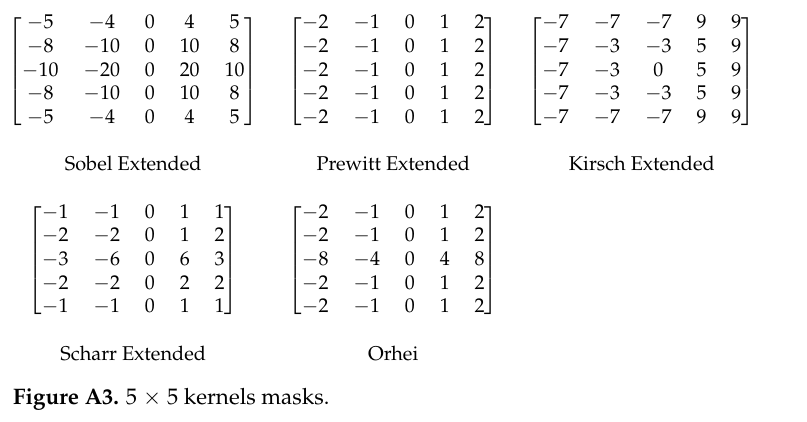
Figure A2. 3 × 3 compass kernel masks.